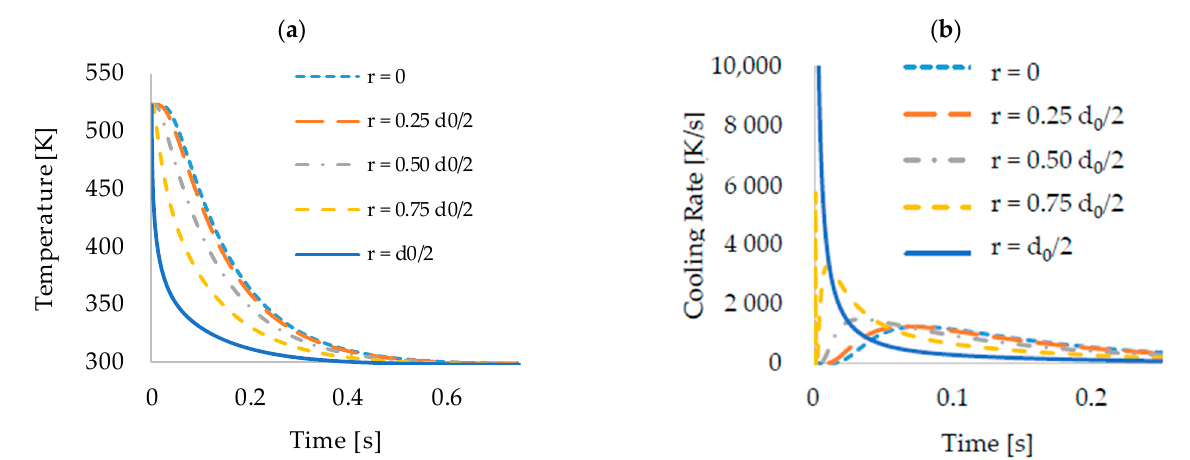
Figure 2. Temperature of the fibre over the time ( a ) it has spent in the bath and the resulting cooling rates with respect to time ( b ). The results show the different rates of cooling that arise inside the fibre depending on the radial location.